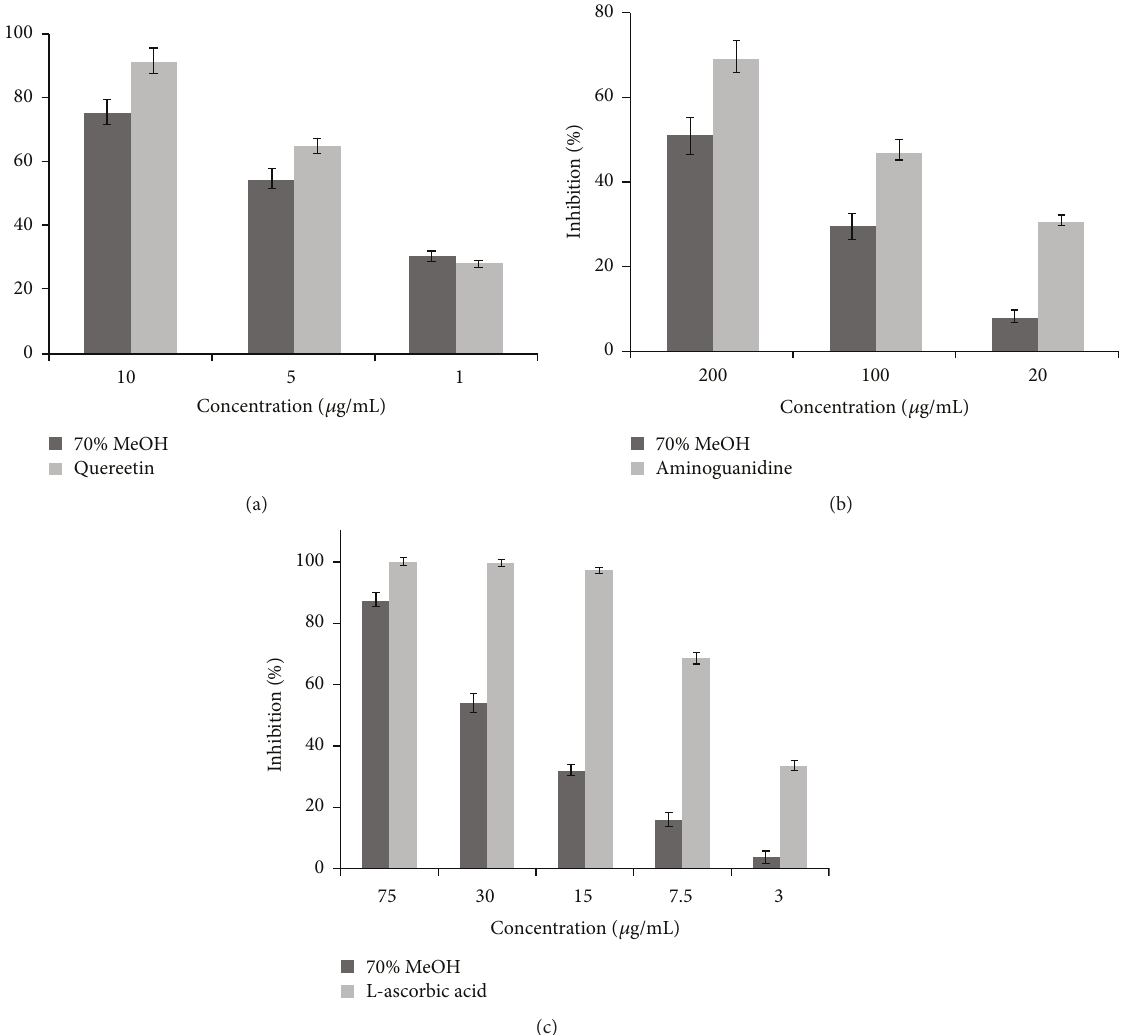
Figure 1: The inhibitory activities by MR crude extract on rat lens aldose reductase (a), advanced glycation end products (b), and DPPH radical-scavenging (c) in various